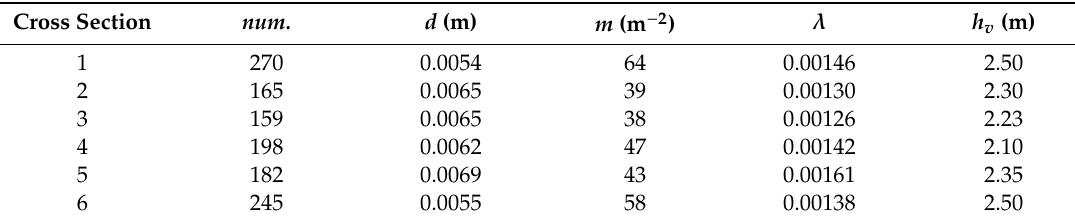
Table 1. Morphometrical vegetation properties measured at the six cross sections: num. is the number of stems in each measuring cross section, d (m) is the average stems’ diameter, m (m − 2 ) is the riparian vegetation density and λ = ( π · m · d 2 / 4) is the riparian vegetation surface density. Cross Section